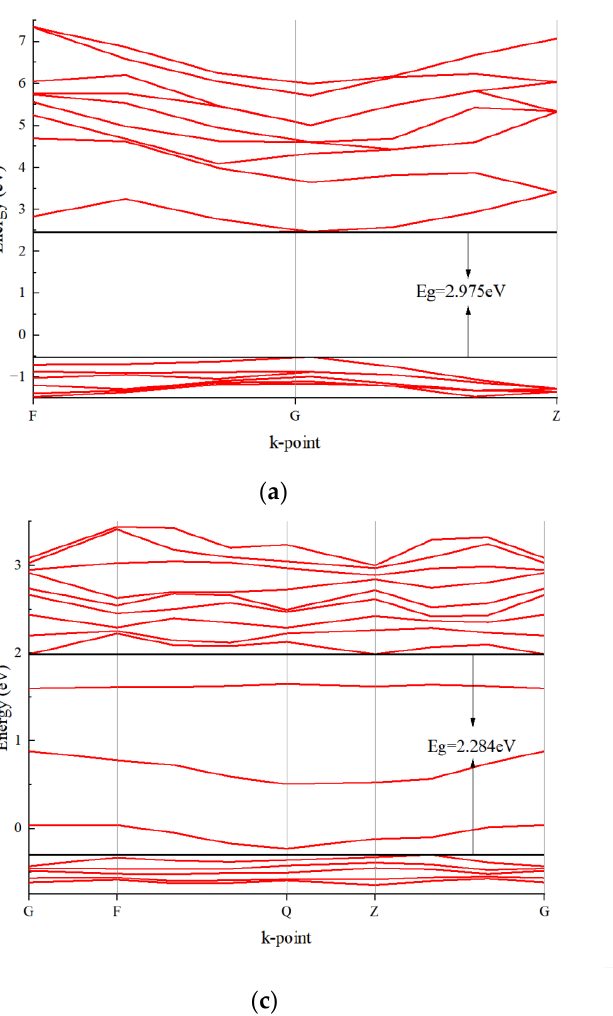
( d ) Figure 8. ( a ) LaNiO 3 primitive unit cell; ( b ) LaNiO 3 2 × 2 × 1 supercell; ( c ) LaNiO 3 2 × 2 × 1 supercell top view; ( d ) La 0.875 Sr 0.125 NiO 3−σ 2 × 2 × 1 supercell top view; 1: substitution position, 2: oxygen va- cancy position. 2.4.1. Band Structure As shown in Figure 9, according to First-principle, the calculation results of the four kinds of supercells show that the band gap width is 2.975 eV, 2.599 eV, 2.284 eV, and 2.074 eV for LaNiO 3 , LaNiO 3−σ , La 0.875 Sr 0.125 NiO 3 , and La 0.875 Sr 0.125 NiO 3−σ , respectively. It can be observed that compared with LaNiO 3 , the conduction band level of LaNiO 3−σ decreases, which leads to a narrower band gap width. The same situation occurs in La 0.875 Sr 0.125 NiO 3 , whose band gap width is even smaller than that of LaNiO 3−σ . Moreover, La 0.875 Sr 0.125 NiO 3−σ